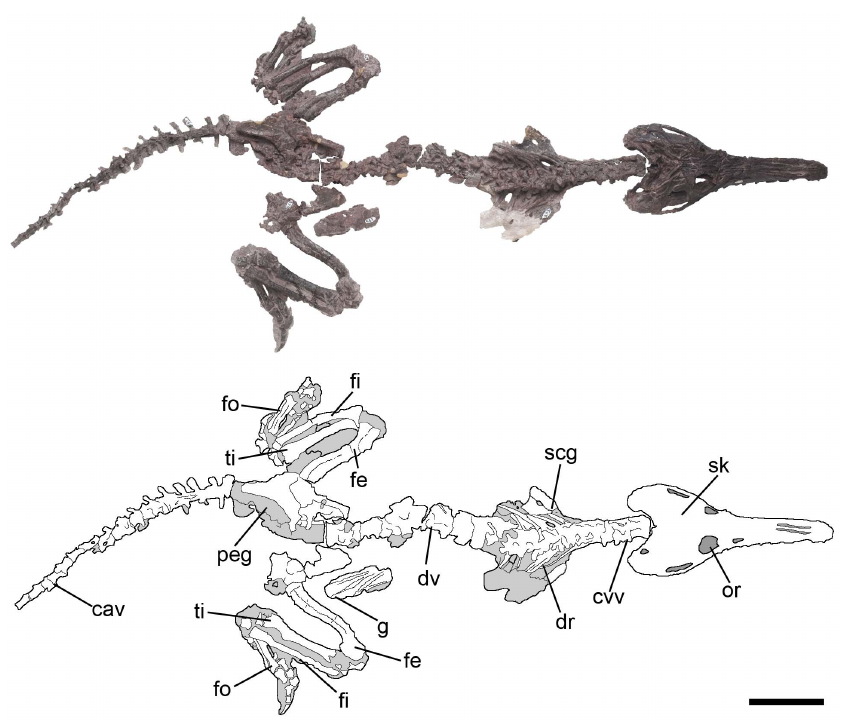
Figure 1. Holotype of Pseudochampsa ischigualastensis (PVSJ 567) as it was found in the field. Abbreviations: cav, caudal vertebrae; cvv, cervical vertebrae; dr, dorsal ribs; dv, dorsal vertebrae; fe, femur; fi, fibula; fo, foot; g, gastralia; or, orbit; peg, pelvic girdle; scg, scapular girdle; sk, skull; ti, tibia. Scale bar equals 5 cm.